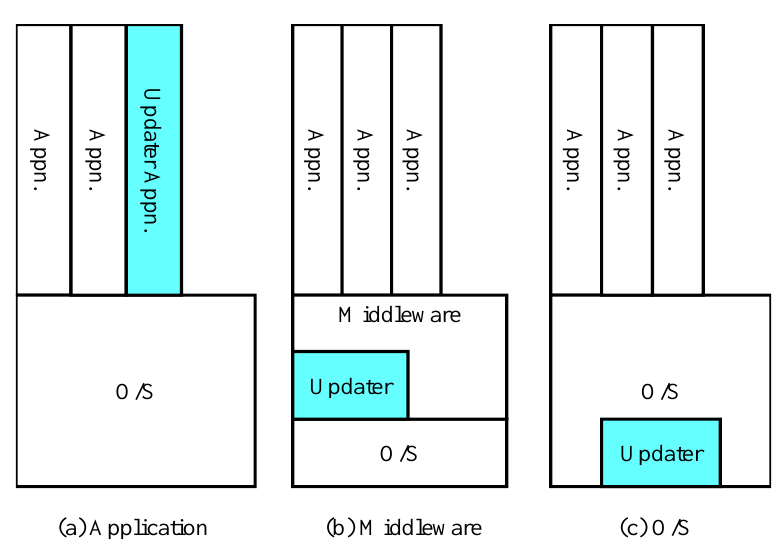
Figure 5. Execution